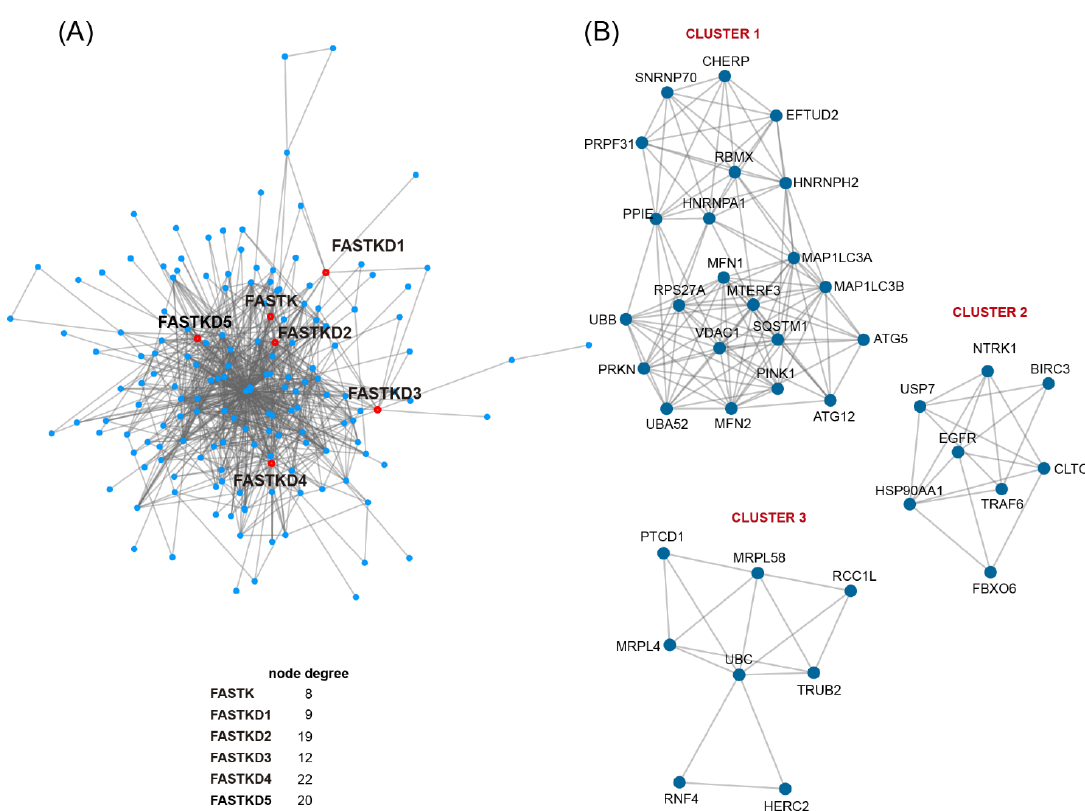
Figure 4. Protein interaction network of FASTK members. Left panel ( A ) shows the FASTKs PPI network. Right panel ( B ) shows the three clusters of most densely connected proteins and the Gene Set/Pathway enrichment analyses.